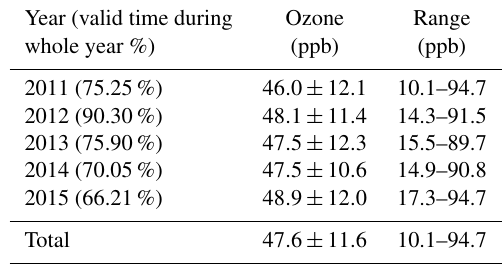
Table 1. Statistical summary of surface ozone at Nam Co Station from 2011 to